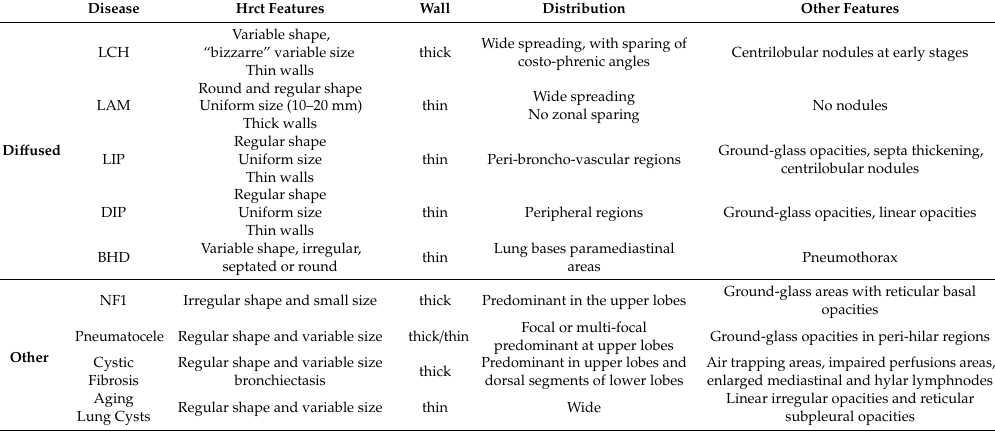
The main high-resolution computed tomography (HRCT) features, wall thickness (thick or thin cut-o ff : 2 mm) and distribution of cysts, plus associated features in Langerhans (LIP), desquamative interstitial pneumonitis (DIP), neurofibromatosis (NF1), Birt–Hogg–Dub è (BHD) syndrome, pneumatoceles, cystic fibrosis and aging lung cysts are